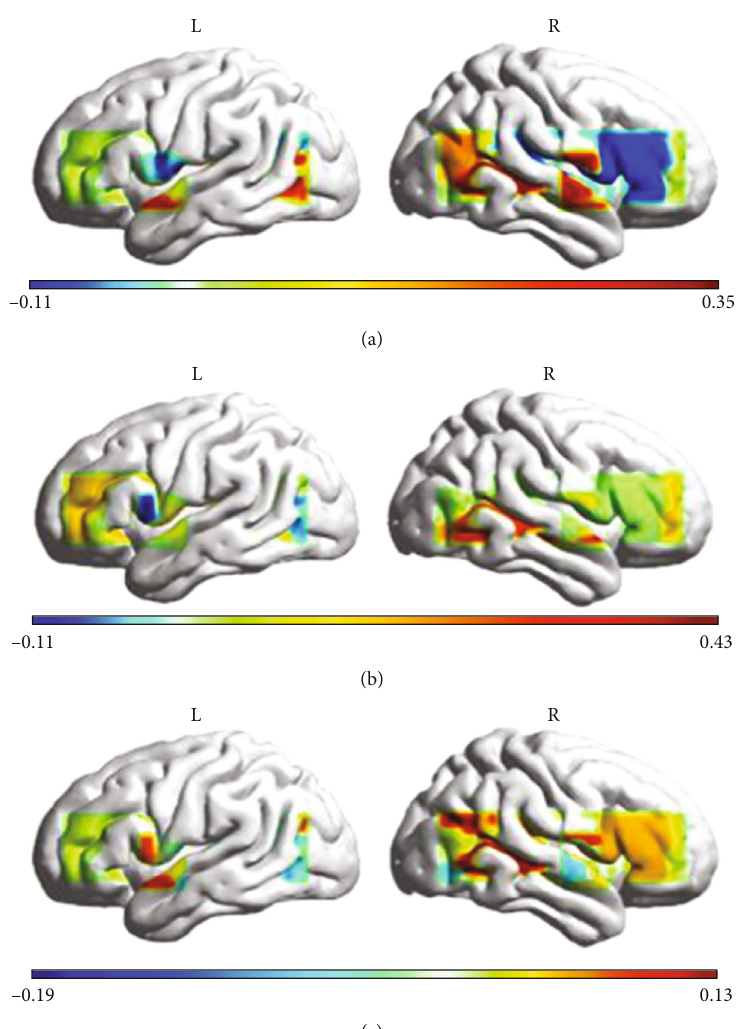
Figure 3: Brain activation study to identify the signi fi cant ROIs in the three conditions: (a) metaphor ( p < 0 : 05 ∗ ); (b) literal; (c)